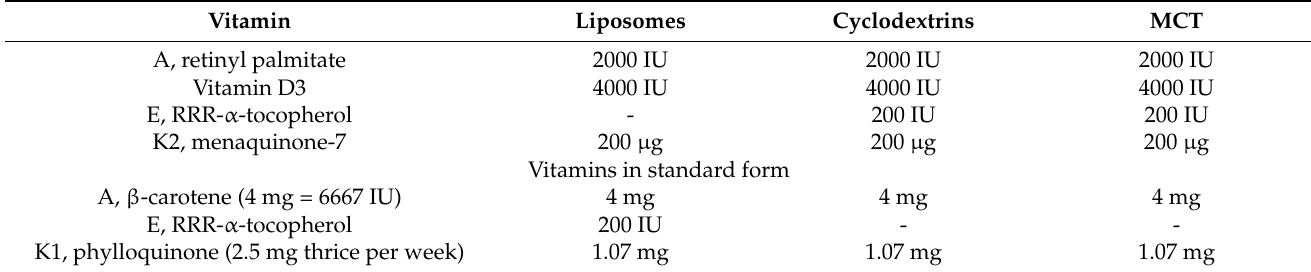
Table 1. Daily vitamin doses in the study